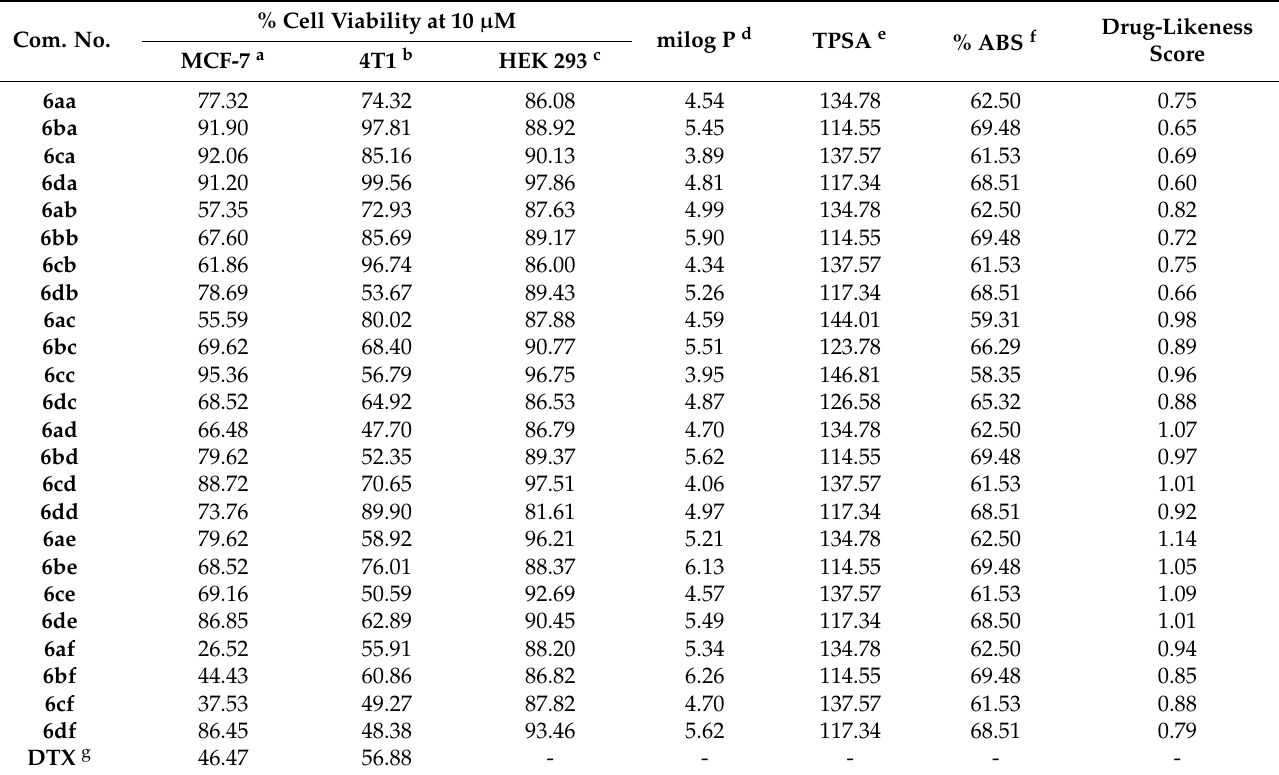
Table 2. In vitro cytotoxicity of compounds ( 6aa – 6df ) against two different cancer cell lines and normal human kidney cell line. Com.